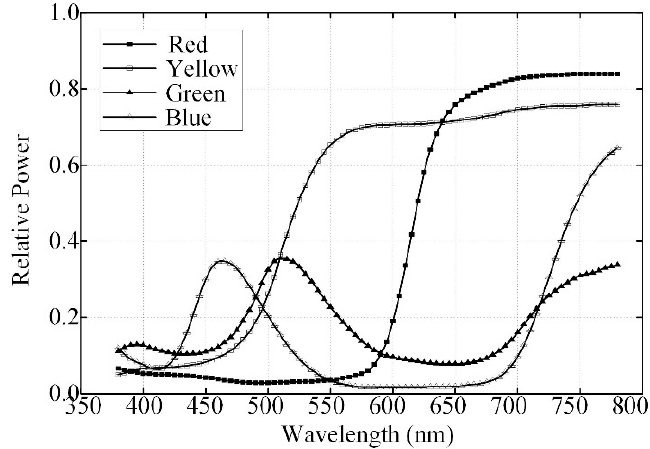
Figure 6. Spectral reflectance distribution of four surface colors. L mes_new is calculated according to the spectral data of light sources, target surface, and luminous efficiency functions of the human eye using Equation (6). The calculation results are shown in Figure 7.